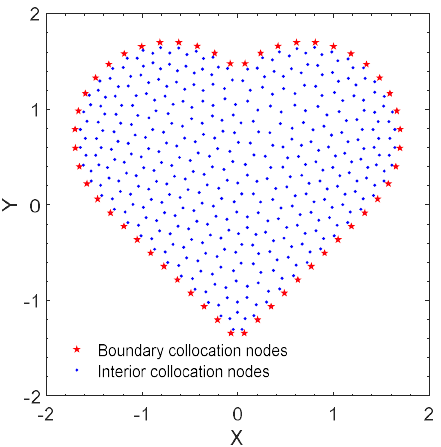
Figure 4. Distribution of 464 collocation nodes.